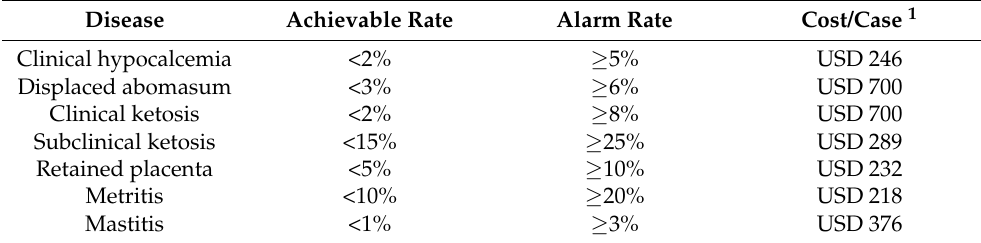
Table 2. Achievable and herd alarm levels and cost/case for the most common diseases observed in dairy cows in the United